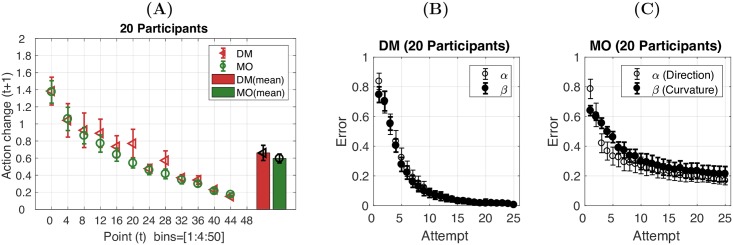
The score-effect on action selection and error reduction in the decision-making task (DM) and the reaching task (MO).(A) Action change on attempt t+1 (y-axis) following a score (points) received on attempt t (x-axis) in the DM task (red) and MO task (green). Bar plot represents average across points. (B-C) Error in α and β (y-axis) plotted against the number of attempts (x-axis) in the DM task (B) and MO task (C). Error bars in all panels represent 95%CI across 20 participants.